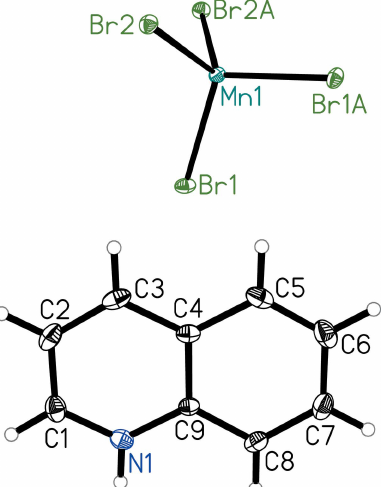
Figure 1 The molecular entities of the title compound with atom labelling and displacement ellipsoids drawn at the 30% probability level.